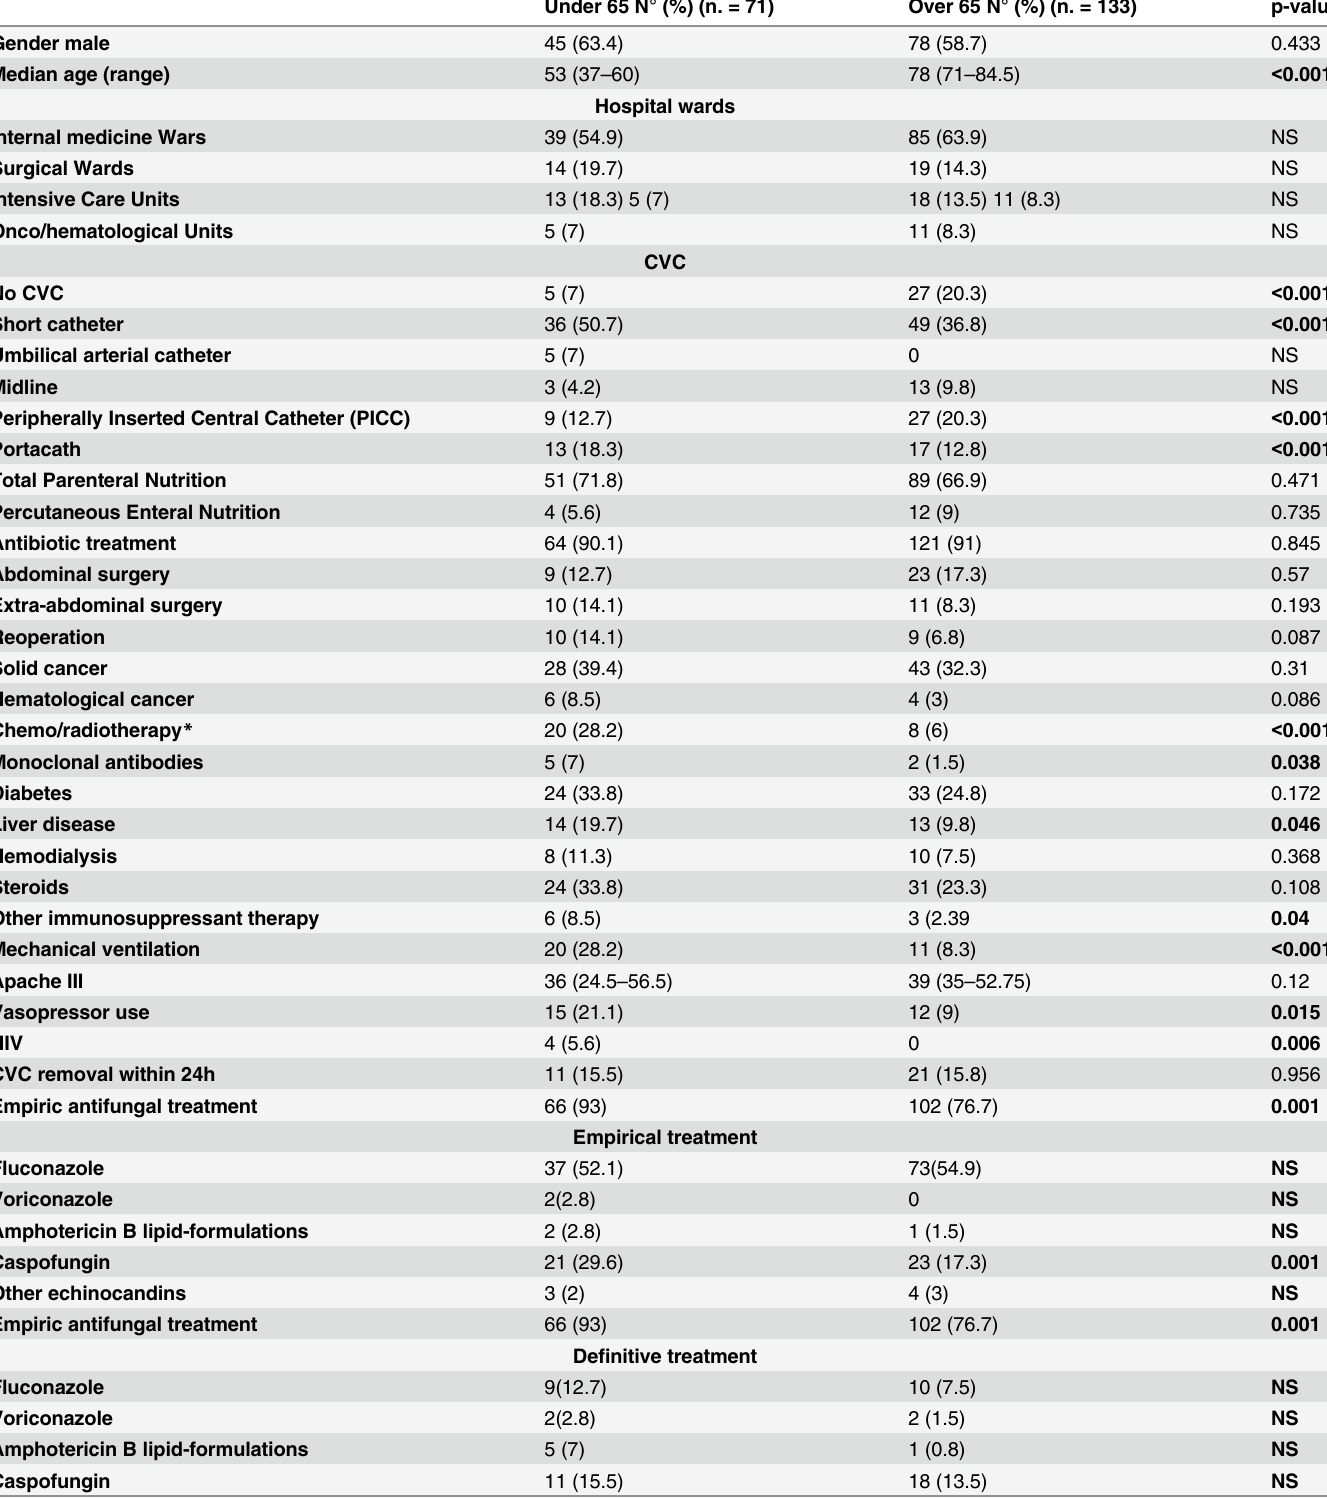
Table 3. Comparison of clinical characteristics between patients under and over 65 years